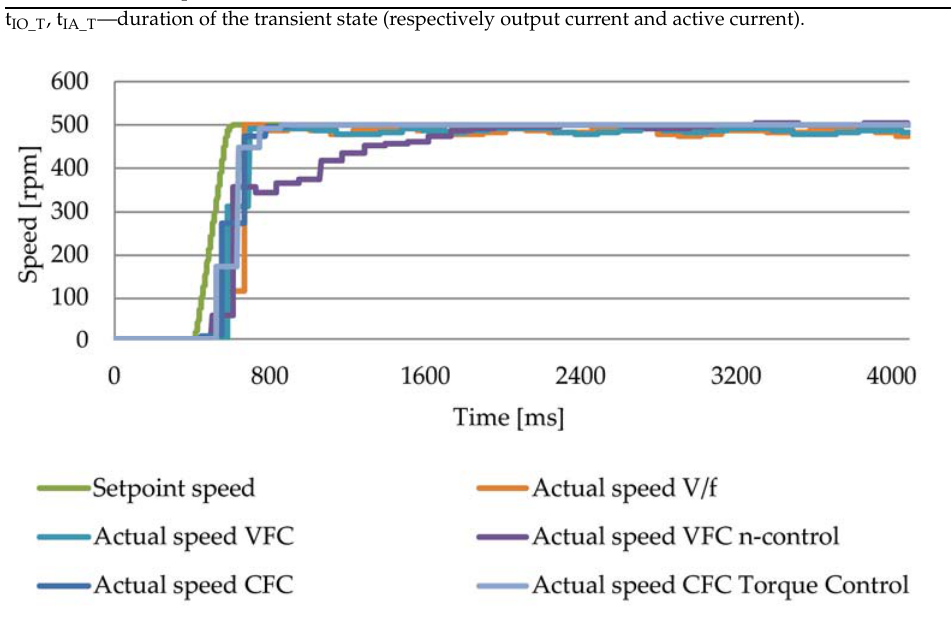
Table 13. Time characteristics of the output current (I O ) and the active current (I A ) in the transient state (with the external load).